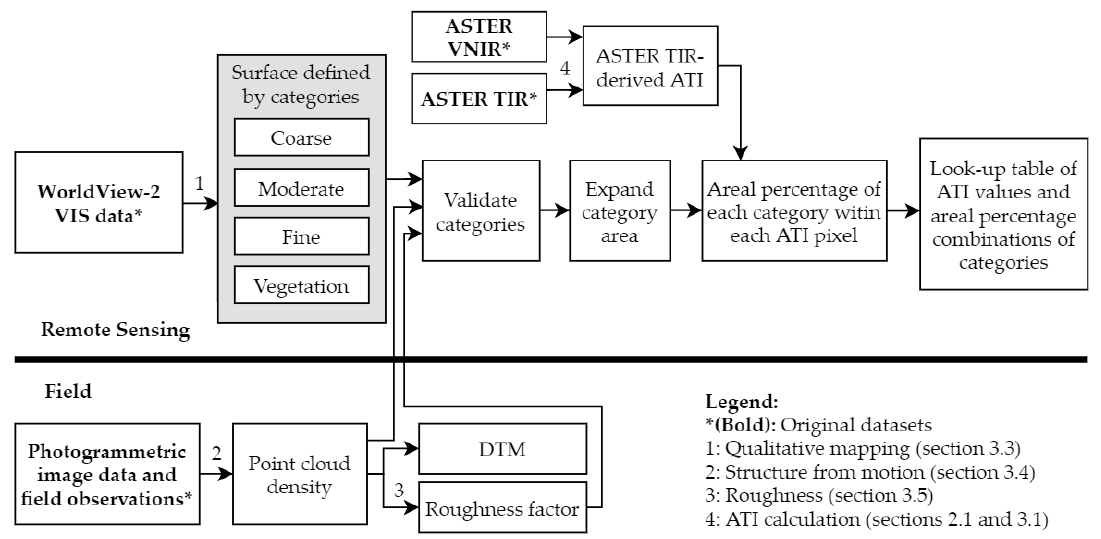
Figure 1. Flowchart of the methodology used to determine the relationship between particle size and apparent thermal inertia (ATI).